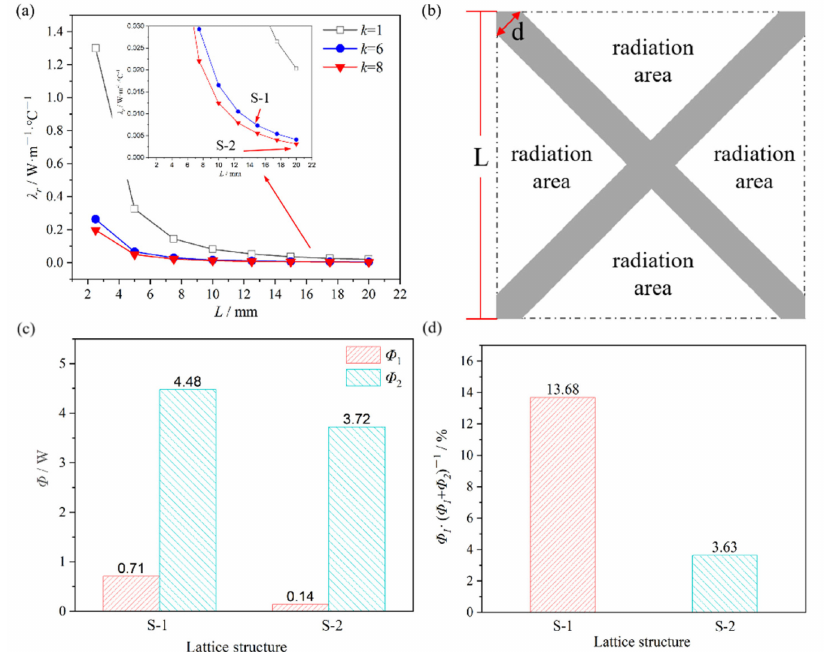
Figure 7. Calculation of lattice thermal conduction performance: ( a ) Equivalent coefficient of thermal conductivity; ( b ) Schematic diagram of thermal radiation; ( c ) Thermal flow of the lattices; ( d ) Ratio of Φ 1 in thermal